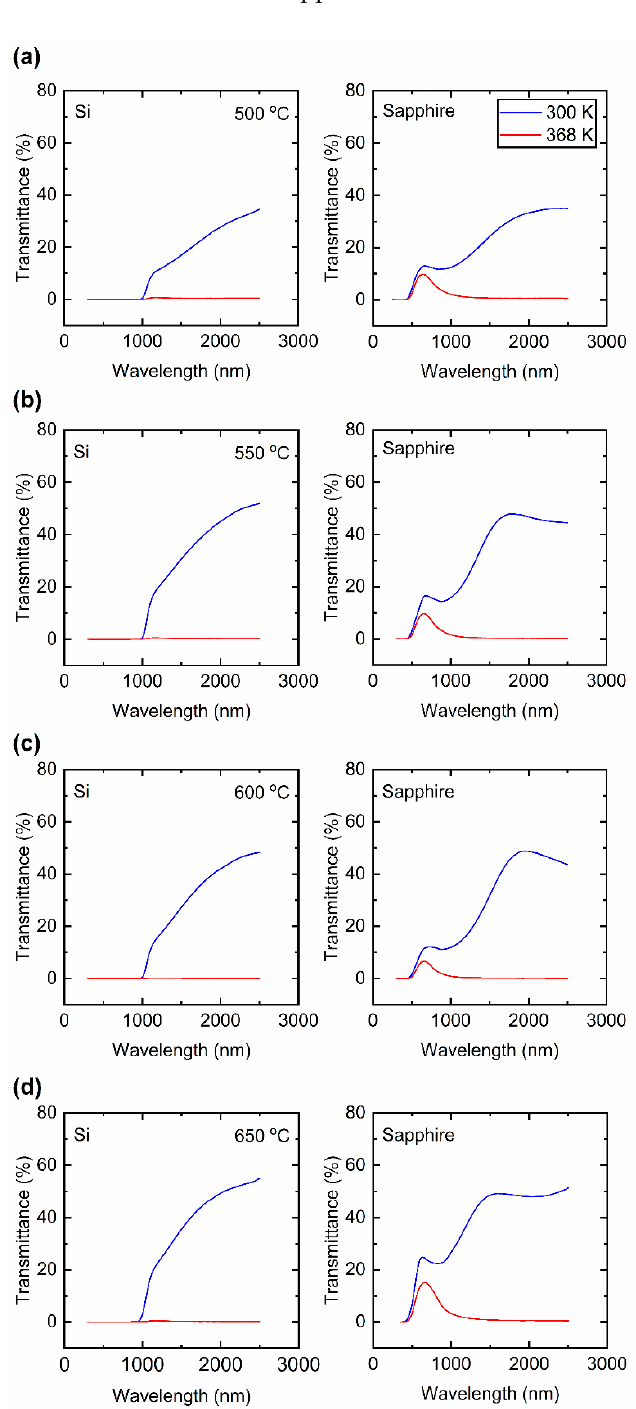
Figure 6. Optical transmittance ( (cid:101) T ) spectra of VO 2 thin films deposited at ( a ) 500 ◦ C, ( b ) 550 ◦ C, ( c ) 600 ◦ C and ( d ) 650 ◦ C [17] on Si and sapphire substrates at 300 K (insulating phase) and 368 K (metallic phase).